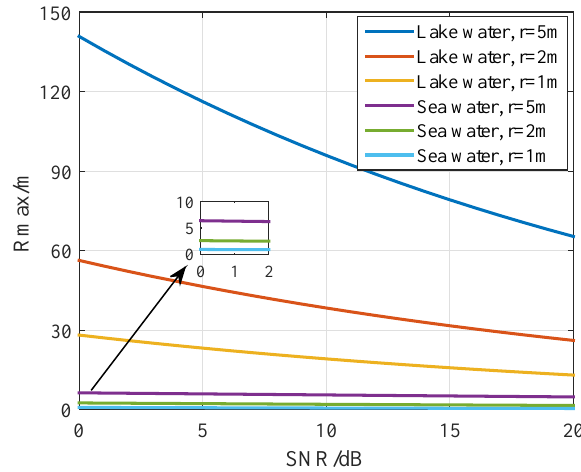
Figure 6. The intra-cluster maximum transmission range.